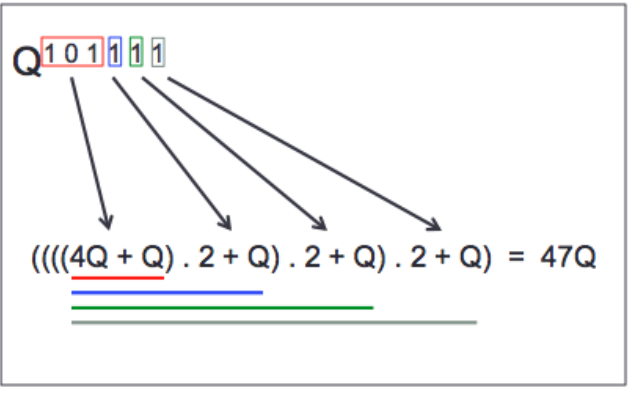
Figure 1. Left-to-Right Proposed